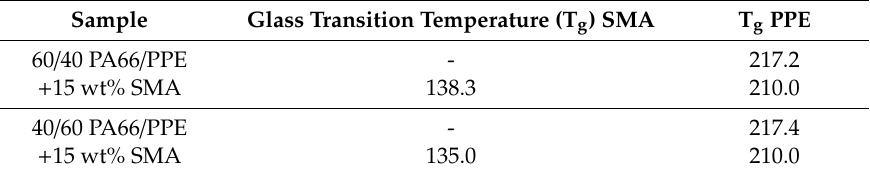
Table 2. Glass transition temperatures ( T g ) of SMA and poly (2,6-dimethyl-1,4-phenylene ether) (PPE) (tan δ maximum) for both references (60/40 and 40/60 PA66/PPE) and 15 wt% SMA content.